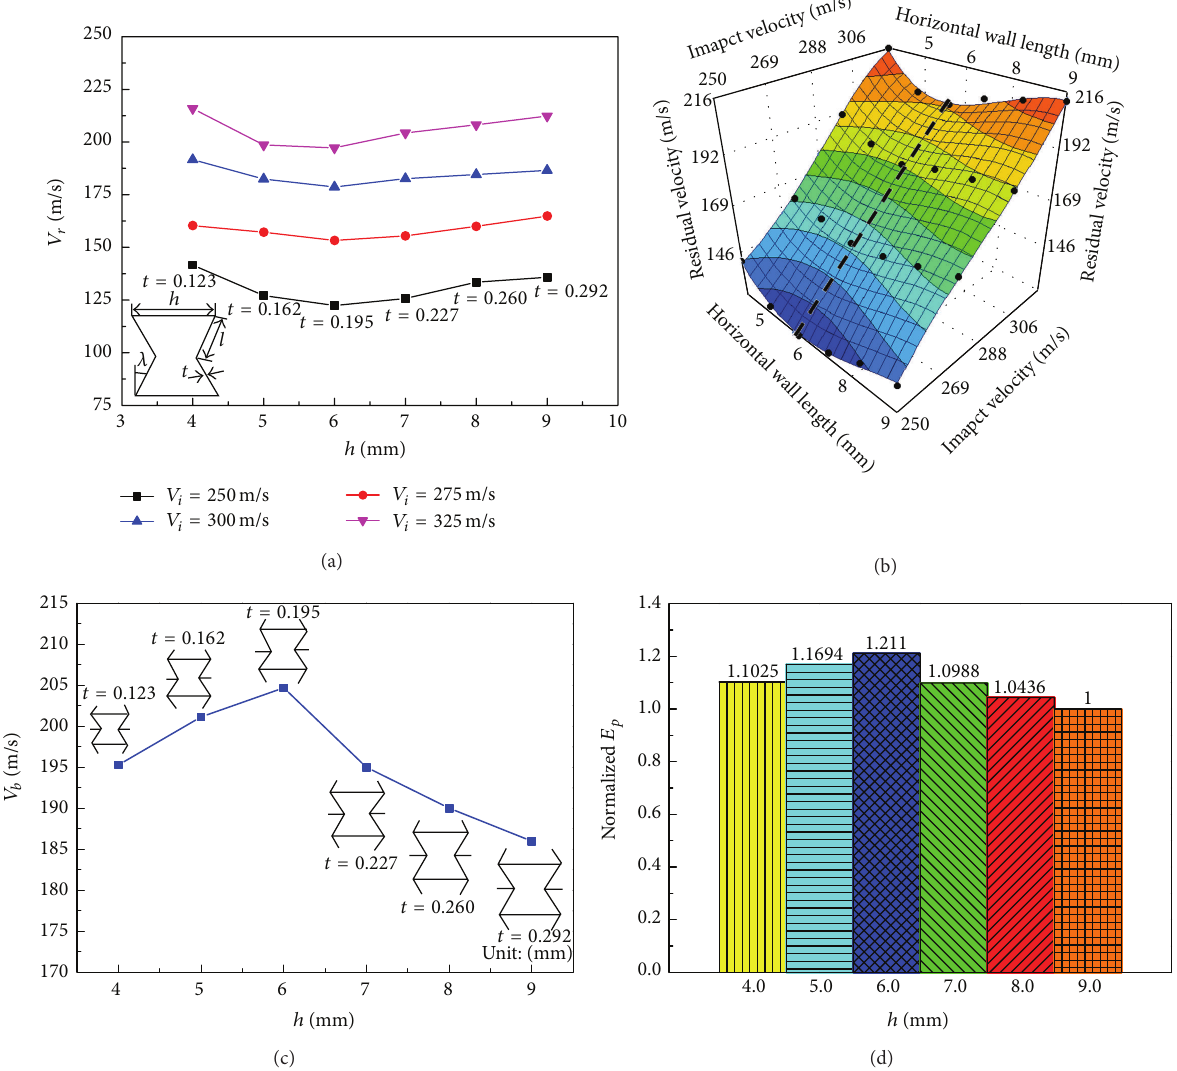
Figure 21: Effects of reentrant unit cell size and wall thickness on the ballistic responses of auxetic HSPs: (a) residual velocity variations with varied cell size and wall thickness at different impact velocities; (b) quartic polynomial approximation surface of residual velocity (The bold black dots in the plot show the training points); (c) ballistic limit versus unit cell horizontal wall length; and (d) normalized minimum perforation energy versus unit cell horizontal wall length. (All numerical specimens have 𝑇 𝑓 = 1.0 mm, 𝑇 𝑐 = 50 mm, 𝜌 = 0.15 , and 𝜆 = −30 ∘